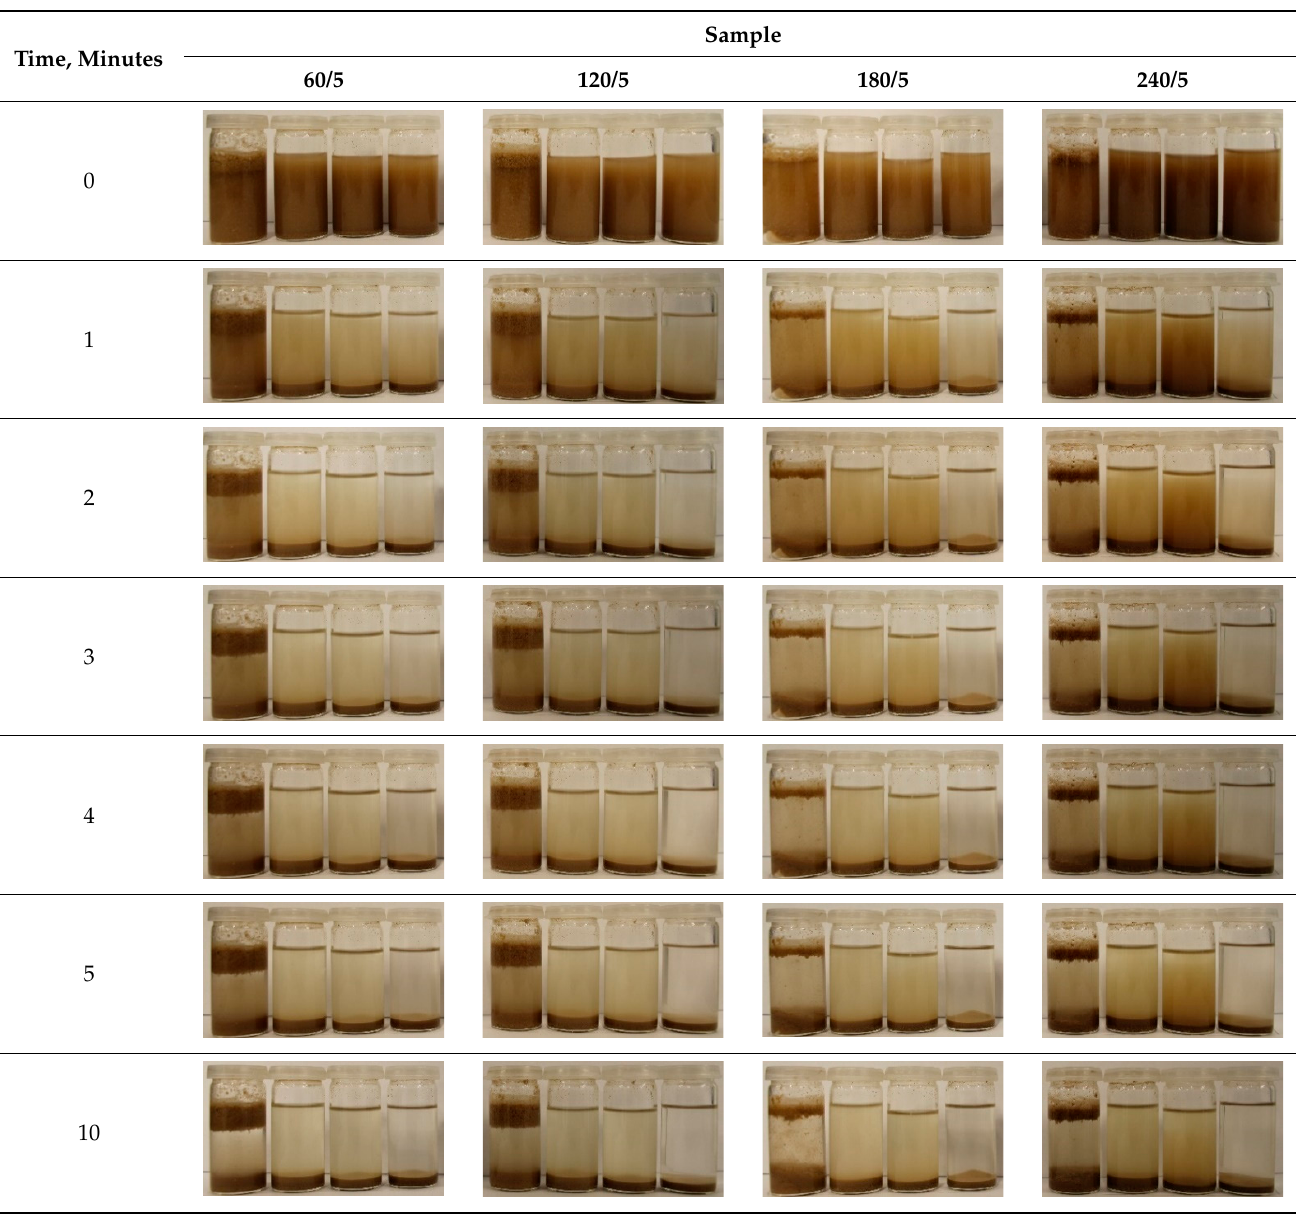
Table 3. The influence of the IPDI modification on the behavior of fillers in particular solvents (from left to right—water, methanol, acetone, n -pentane).